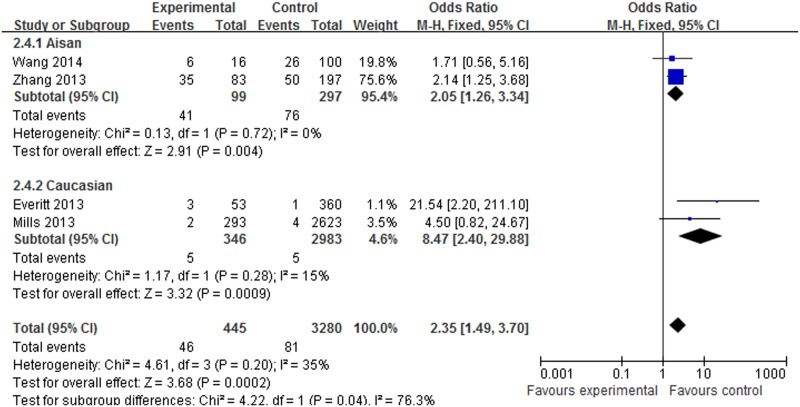
The forest plot for the association between SNP rs12252 of IFITM3 and influenza susceptibility in the recessive model (CC vs. CT+TT), subgroup analysis by different ethnicity.